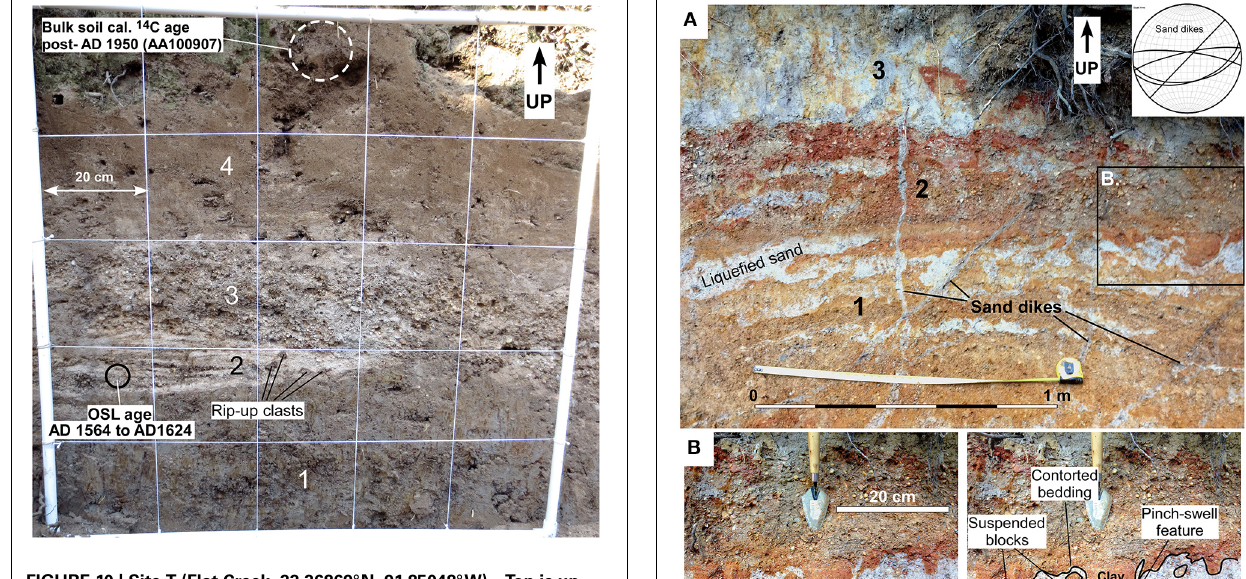
FIGURE 10 | Site T (Flat Creek, 33.36869 ◦ N, 91.85048 ◦ W)—Top is up. Photograph of 1 × 1m grid on vertical excavation. No liquefaction observed. Unit 1, Flat Creek overbank, massive silty clay; Unit 2, Flat Creek point-bar, thin-bedded, fine sand; Unit 3, Flat Creek point-bar, medium-bedded sandy gravel; Unit 4, Flat Creek overbank, massive loam (aggraded A soil horizon). The bulk soil 14 C age from Sample AA100907 post-dates deposition of Units 1 through 3but does not constrain sediment deposition to before the historic period (our minimum constraint). The quartz OSL age ( Table 2 ) gives the age of Unit 2 deposition and pre-dates deposition of Units 3 and 4.